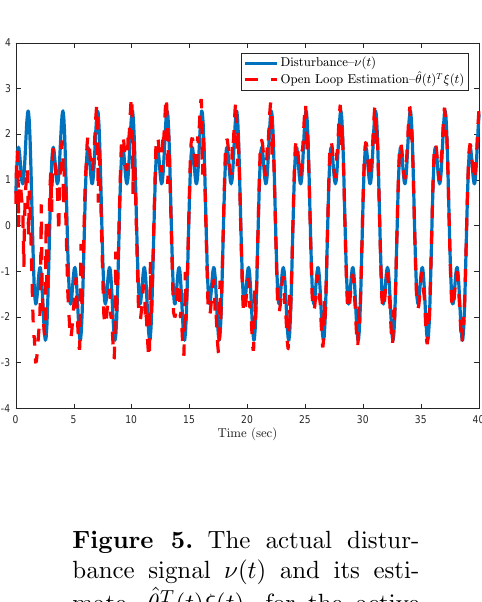
Figure 5. The actual distur- bance signal ν ( t ) and its esti- mate, ˆ θ T ( t ) ξ ( t ), for the active